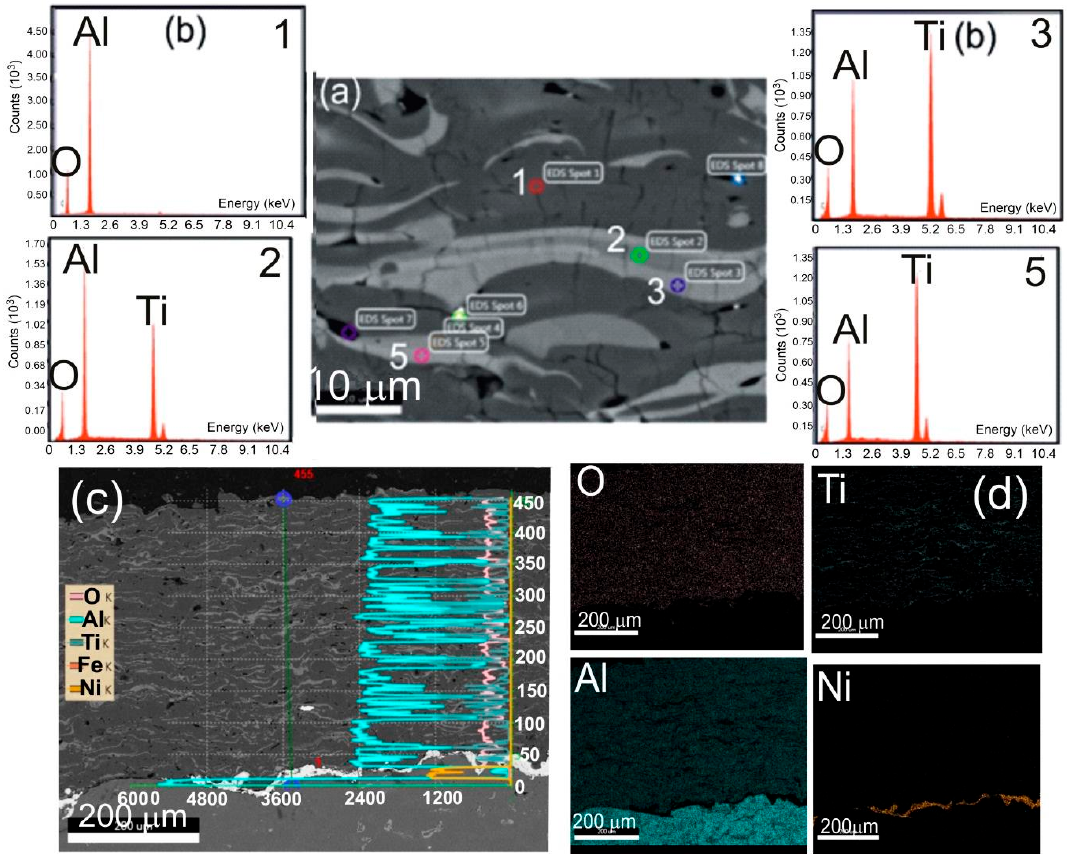
Figure 4. Scanning micrographs of HVOF sprayed Al 2 O 3 -15 wt.% TiO 2 coating with the NiAl interlayer on the Al-Si cast alloy: ( a ) SEM image; with ( b ) EDS spectra taken from the marked points: 1, 2, 3, and 5; ( c ) linear distribution of concentrations of O, Ti, Al, Fe, and Ni; and ( d ) map of distribution of concentrations of O, Ti, Al, and Ni taken from the region of the coating-substrate interface.